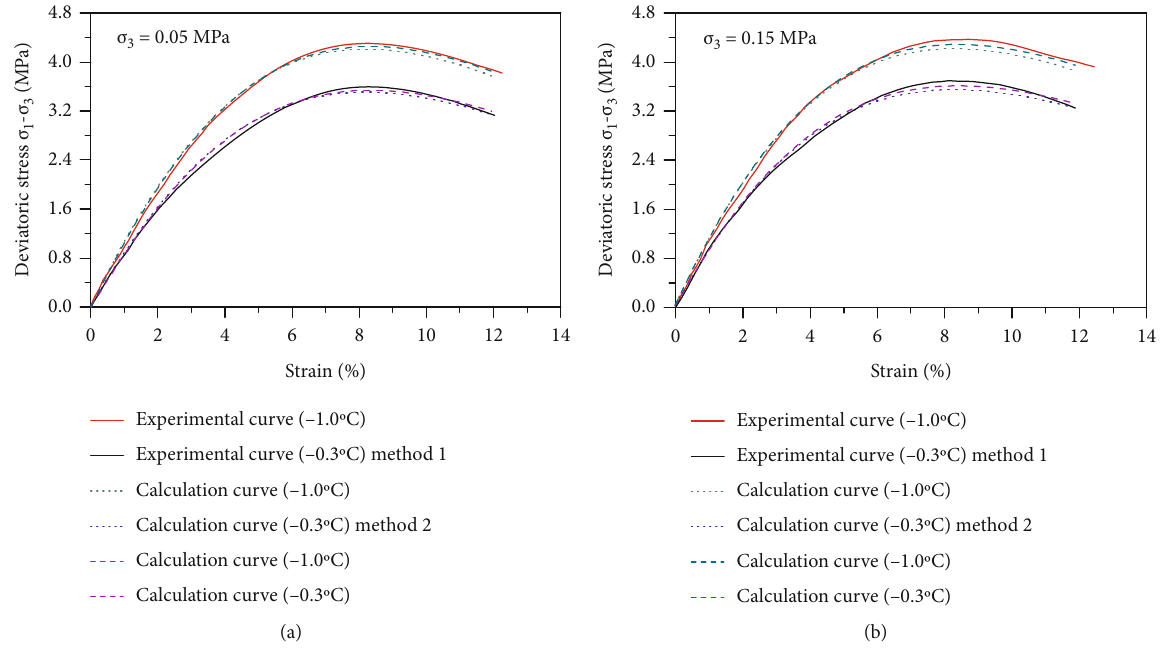
Figure 6: Comparison of the calculated values of the -0.3 ° C and -1 ° C damage models when -2 ° C is the nondestructive temperature.